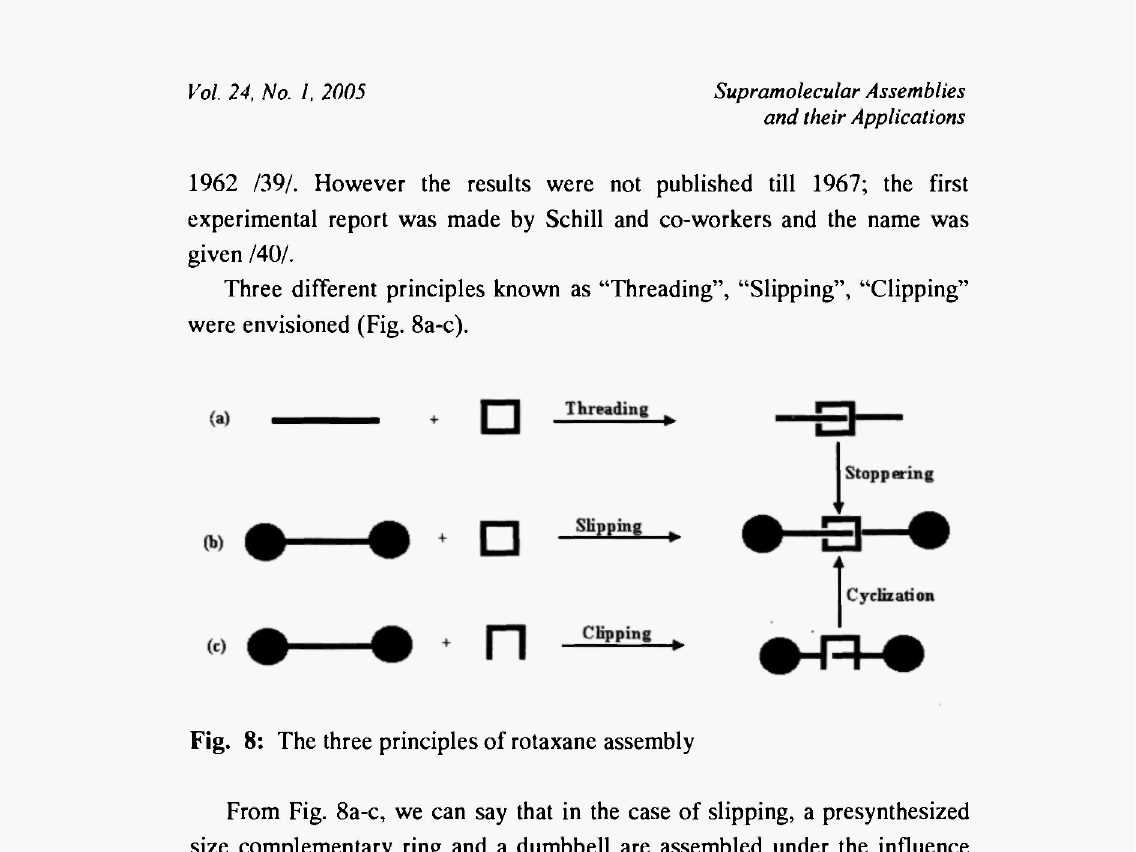
Fig. 8: The three principles of rotaxane